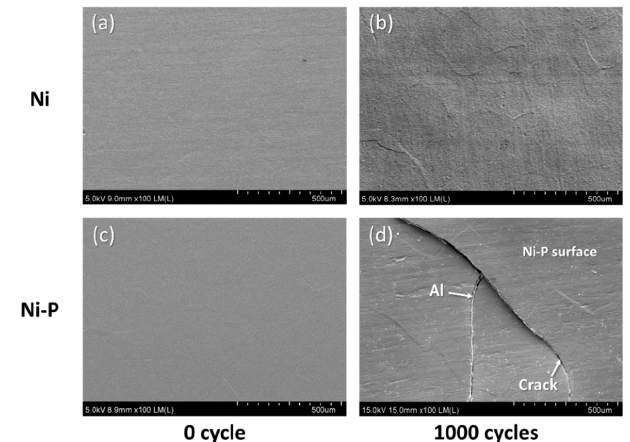
Figure 7. Surface morphology of Ni ( a , b ) and Ni–P ( c , d ) layers on DBA substrates with Si 3 N 4 before and after 1000 cycles.